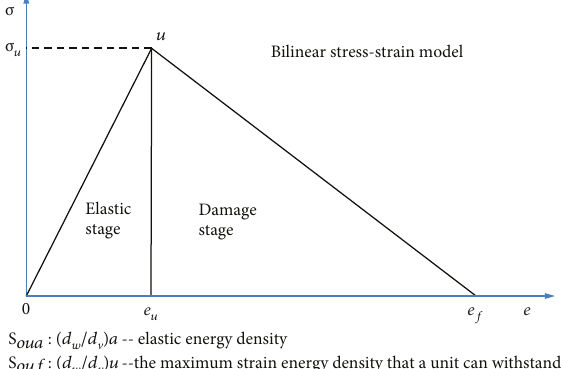
Figure 2: Bilinear stress-strain